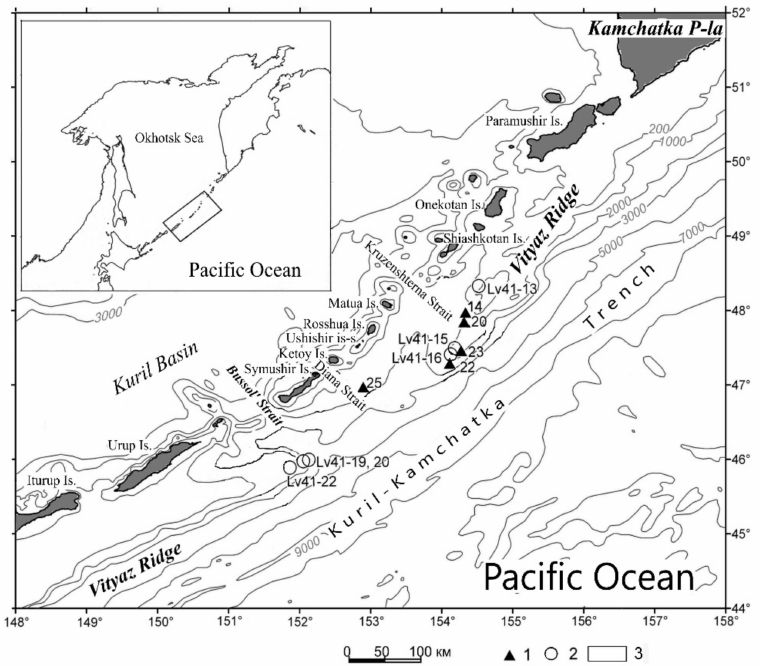
Figure 5. Location of dredging stations for the R/V Akademik M.A. Lavrentiev” [18,19]. 1—stations of the 37th cruise, 2—stations of the 41st cruises, 3—studied area.